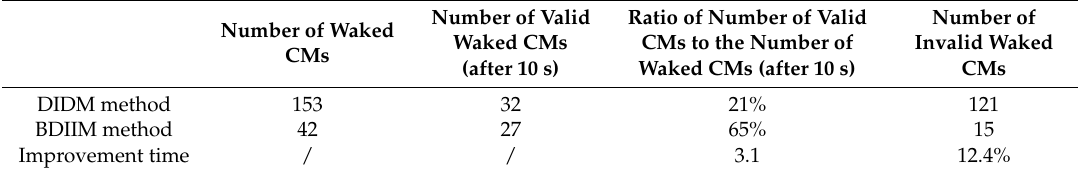
Table 7. The numbers of sending and receiving messages nodes in the WC.